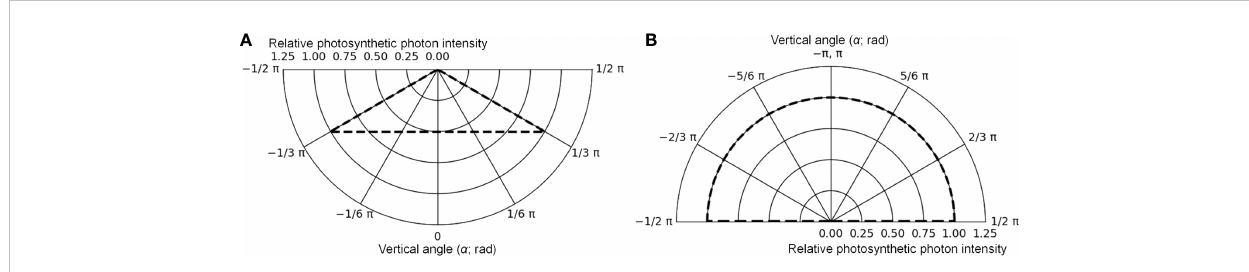
FIGURE 6 The photometric curves of lamps for downward lighting (A) and for upward lighting (B) in the optical simulation. The maximum values were converted to